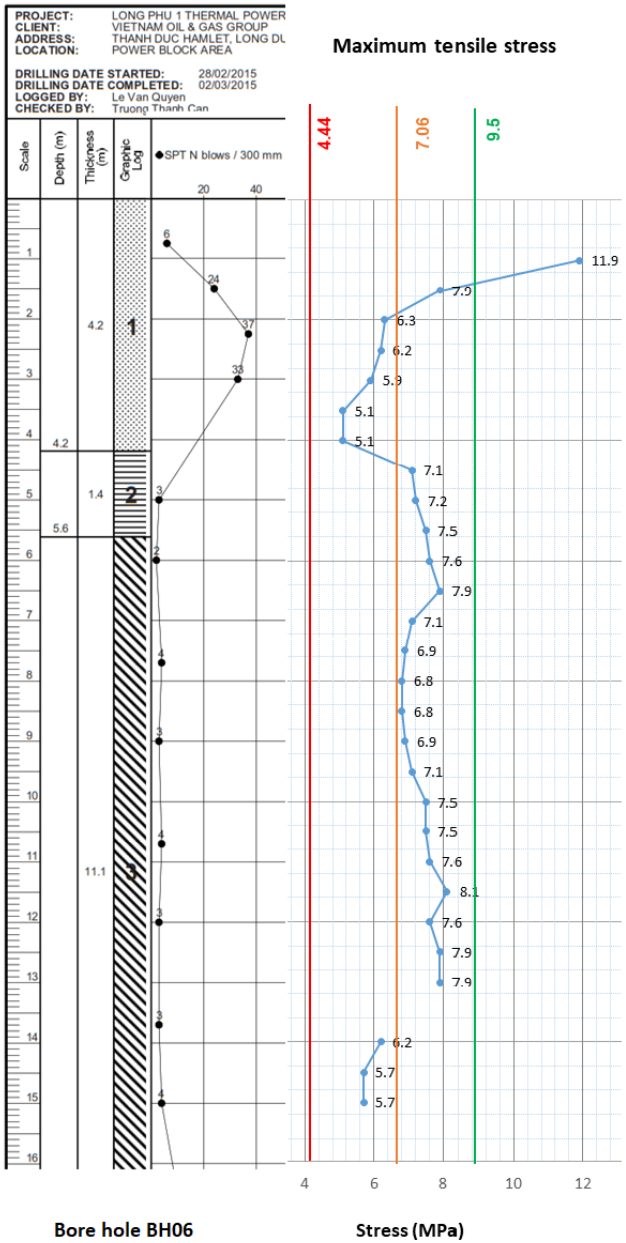
Figure 5. Stress Measurements—First Segment of Pile 12HA 474.